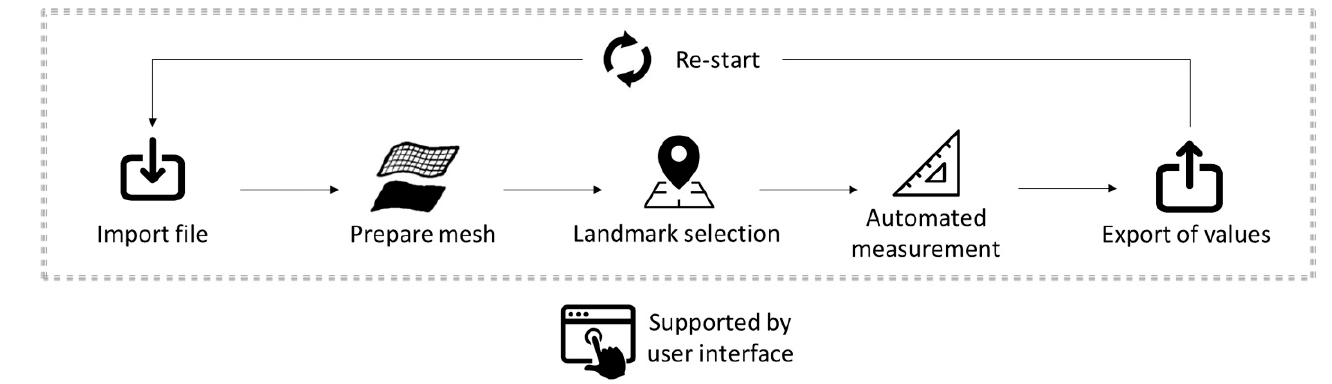
Figure 2. Proposed workflow for a standardized and automated device measurement. All the steps are supported by a user interface (UI).